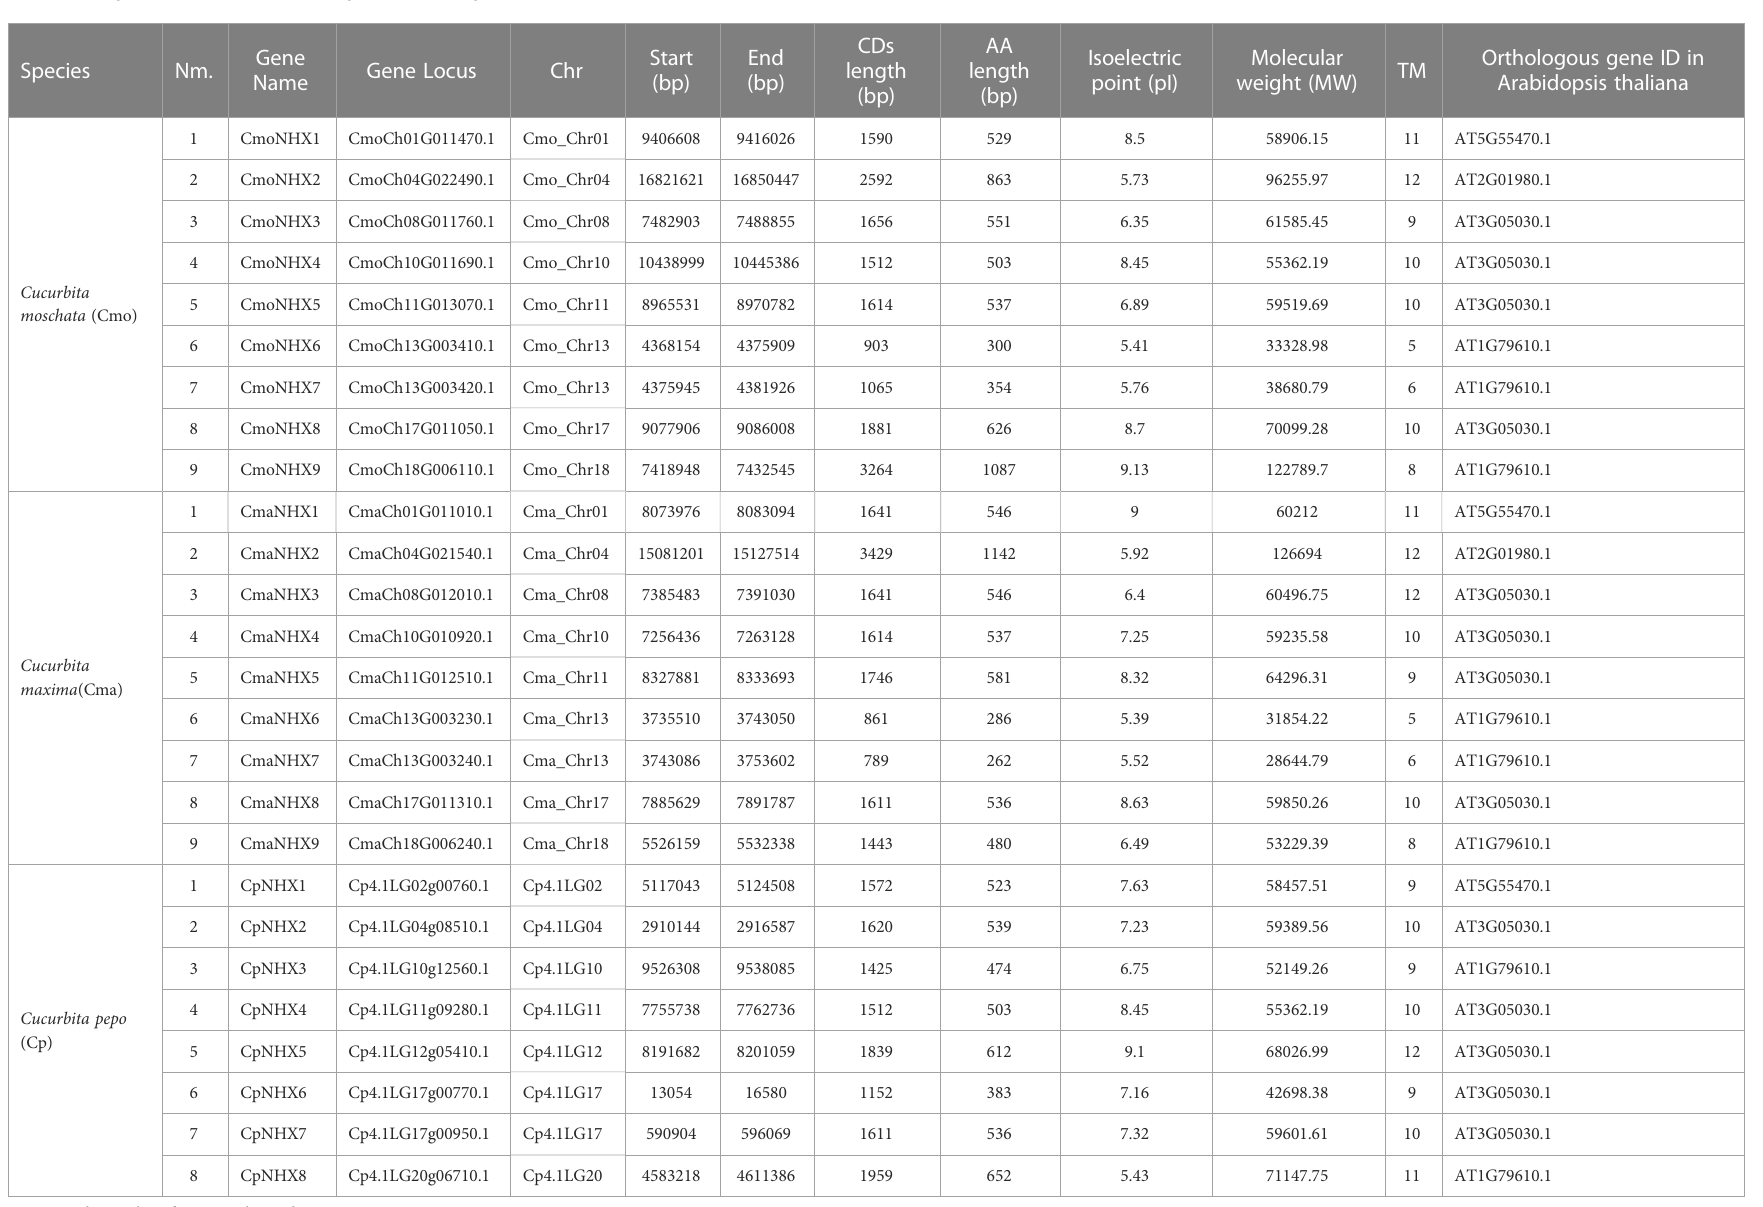
TABLE 1 Properties and locations of the predicted NHX proteins in Cucurbita L.